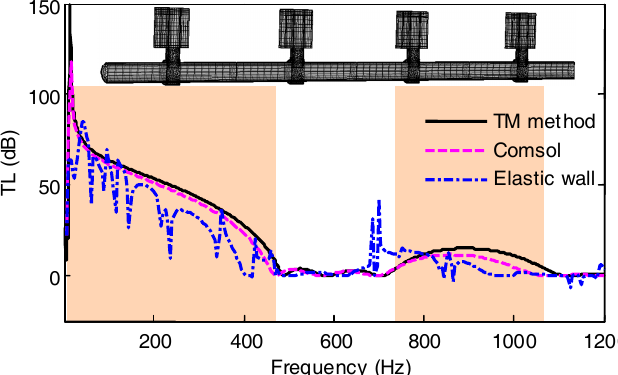
Figure 5. Sound transmission loss of a finite length pipe with four liquid-air HRs attached equidistantly.